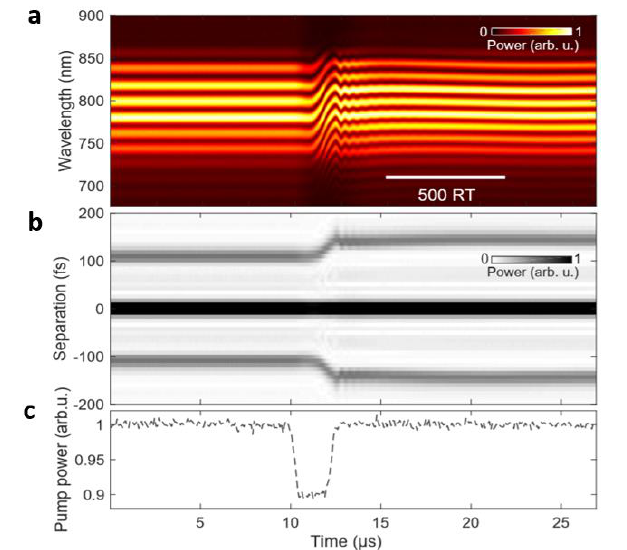
Fig. 2. (a) Experimental consecutive real-time interferograms recorded continuously during a microsecond external modulation of the laser pump power. (b) The respective Fourier-transforms indicate the field autocorrelation and the rapid switching between two distinct bound states of stable separation. (c) The external control is facilitated via the temporal modulation of the pump power via acousto-optic